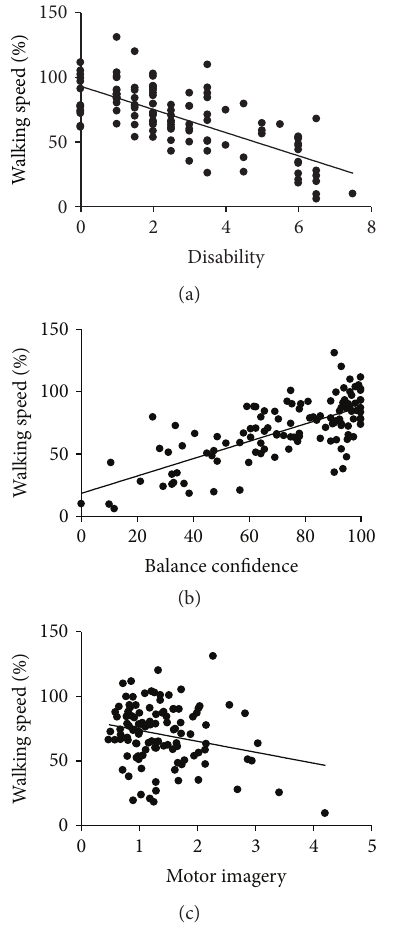
Figure 1: Relationship between walking speed and disability, bal- ance confidence and motor imagery ( 𝑛 = 120 persons with multiple